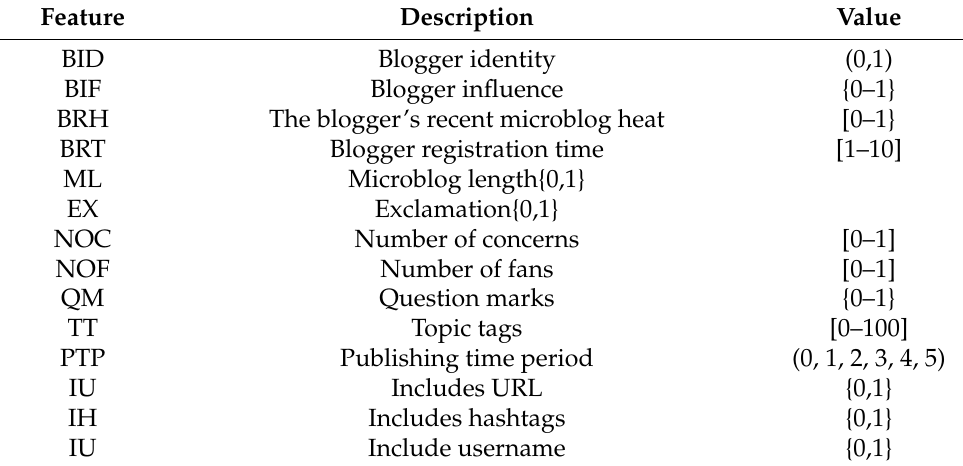
Table 1. Common microblog